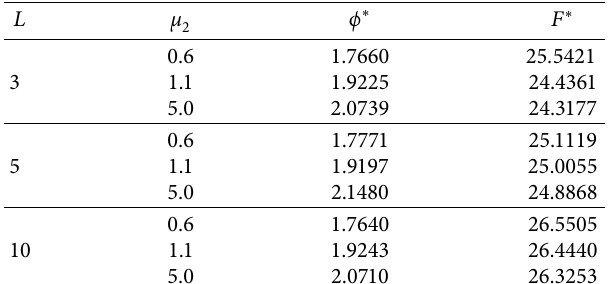
Table 4: Optimal sleep parameters of the proposed scheme. L μ